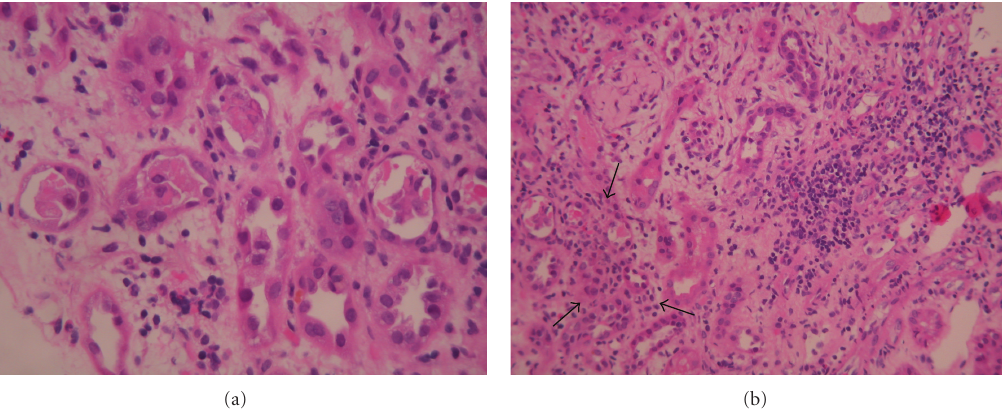
Figure 1: (a) Renal biopsy on hospital day 8 demonstrating focal marked acute tubular injury with cell sloughing seen in the tubular lumena (hematoxylin-eosin, X400). (b) Renal biopsy demonstrating tubulointerstitial nephritis; mild oedema and a focal chronic inflammatory infiltrate (arrows) present with some evidence of acute tubular injury. Cellular and granular cast formation (at left) (hematoxylin-eosin,